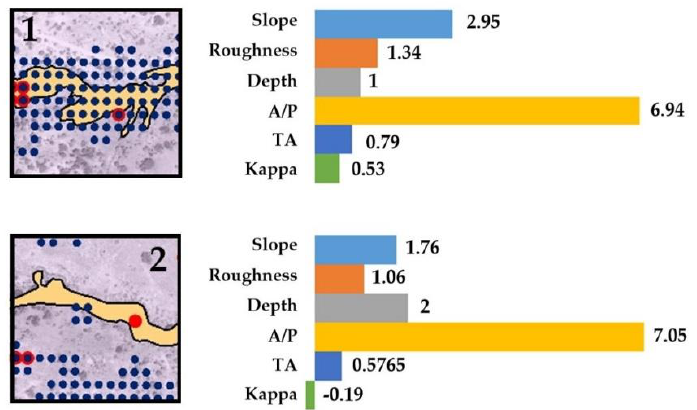
Figure 10. Zonal statistics for Squares 1 and 2 (see Figure 9) of terrain characteristics (slope in degrees, topographic roughness in degrees) and gully morphology (gully depth in meters, ratio area/perimeter — A/P in m 2 /m) and local results (confusion matrix) of MPCA algorithm.